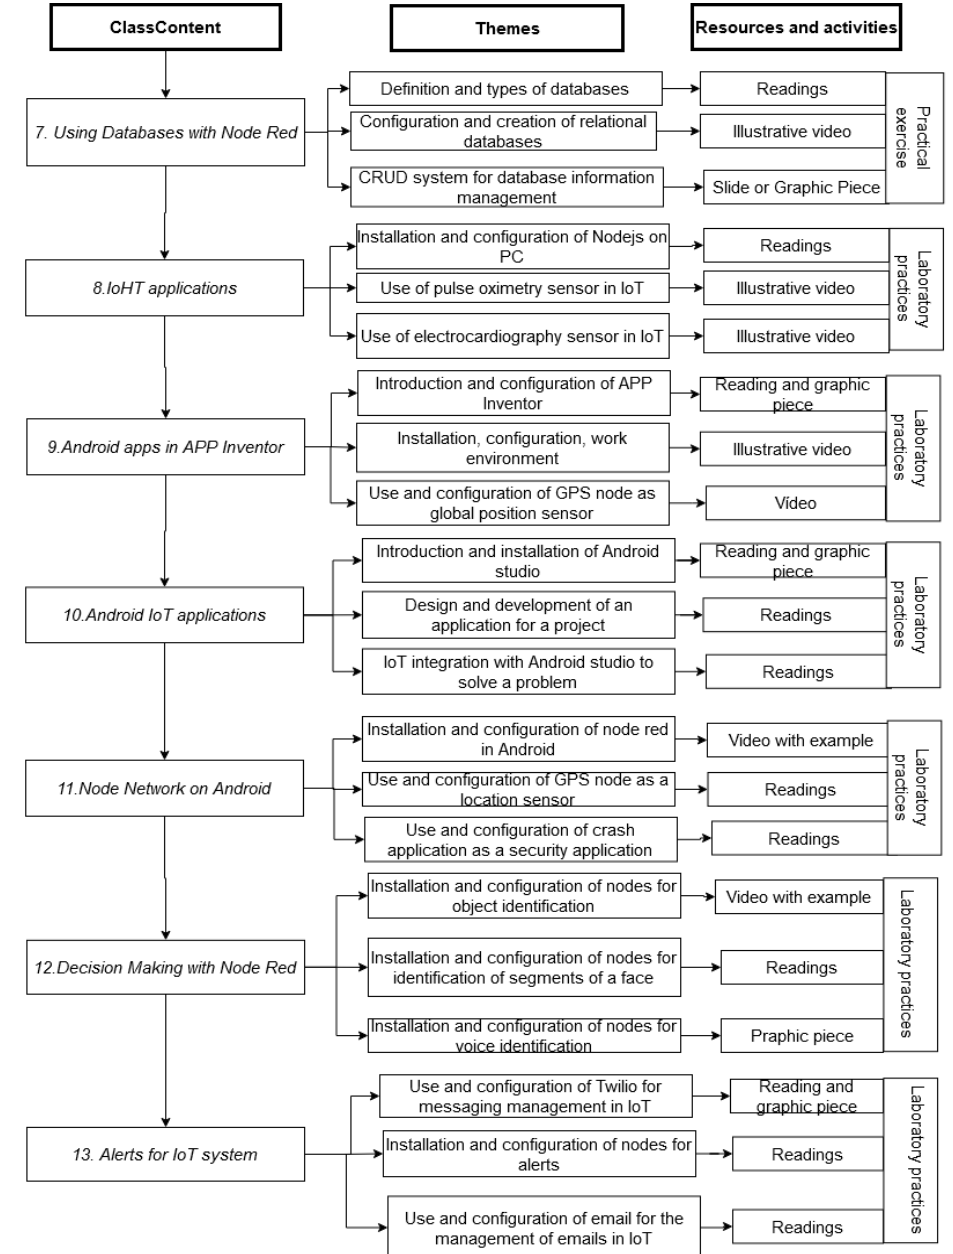
Figure 7. The content structure of the subject from Modules Seven to Thirteen.